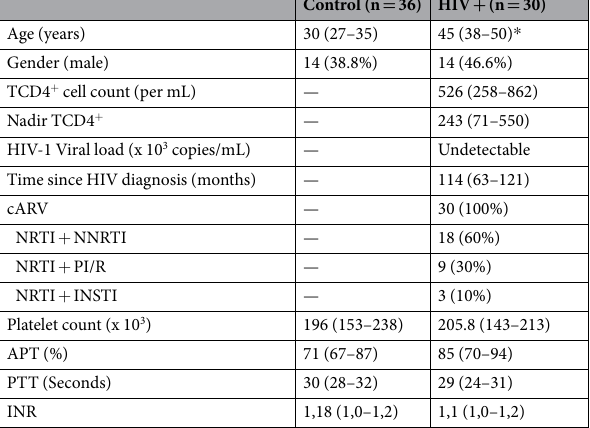
Table 1. Clinical and laboratory characteristics of controls and HIV-infected individuals. Results are expressed as median and interquartile range (IQR). NRTI, nucleoside reverse transcriptase inhibitor; NNRTI,